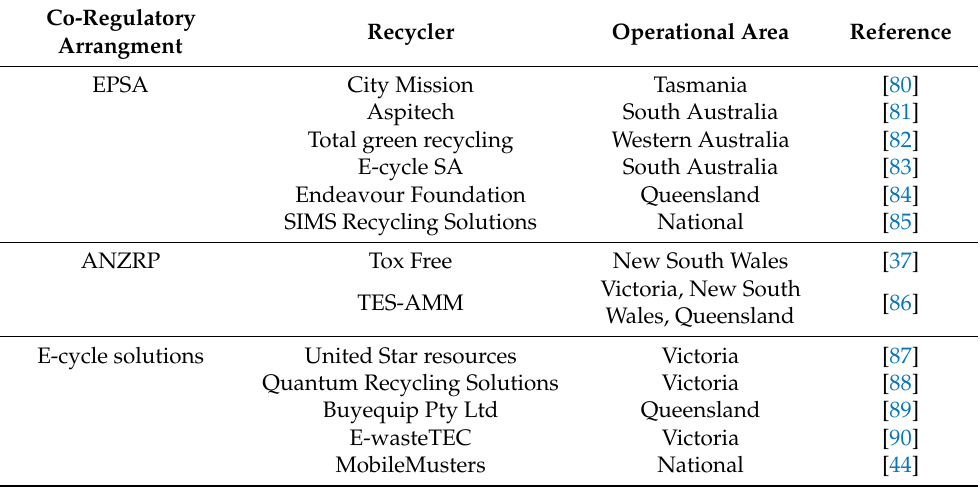
Table 2. List of some recyclers partnered with CRA and their operational area in